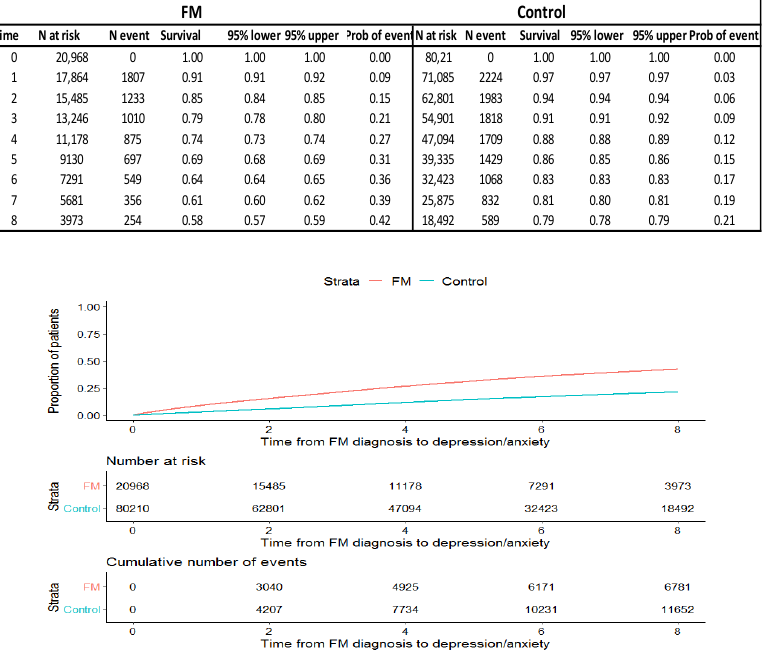
Figure 1. Kaplan–Meier survival curve for anxiety and/or depression from 2010–2017, separating Figure 1. Kaplan – Meier survival curve for anxiety and/or depression from 2010 – 2017, separating patients according to the general population ’s FM prevalent population and FM incidence popula- patients according to the general population’s FM prevalent population and FM incidence tion. (Figure 2) Kaplan – Meier survival curve for the outcome according to sex at eight years.